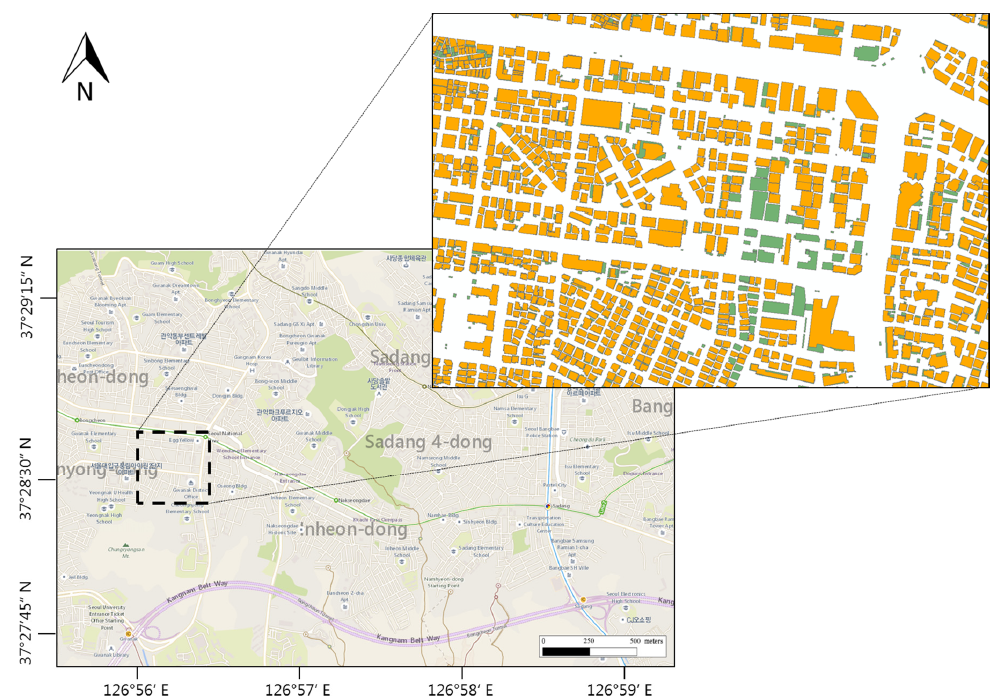
Figure 2. Test area represented in a Bing map. The magnified inset is the area where the changes are